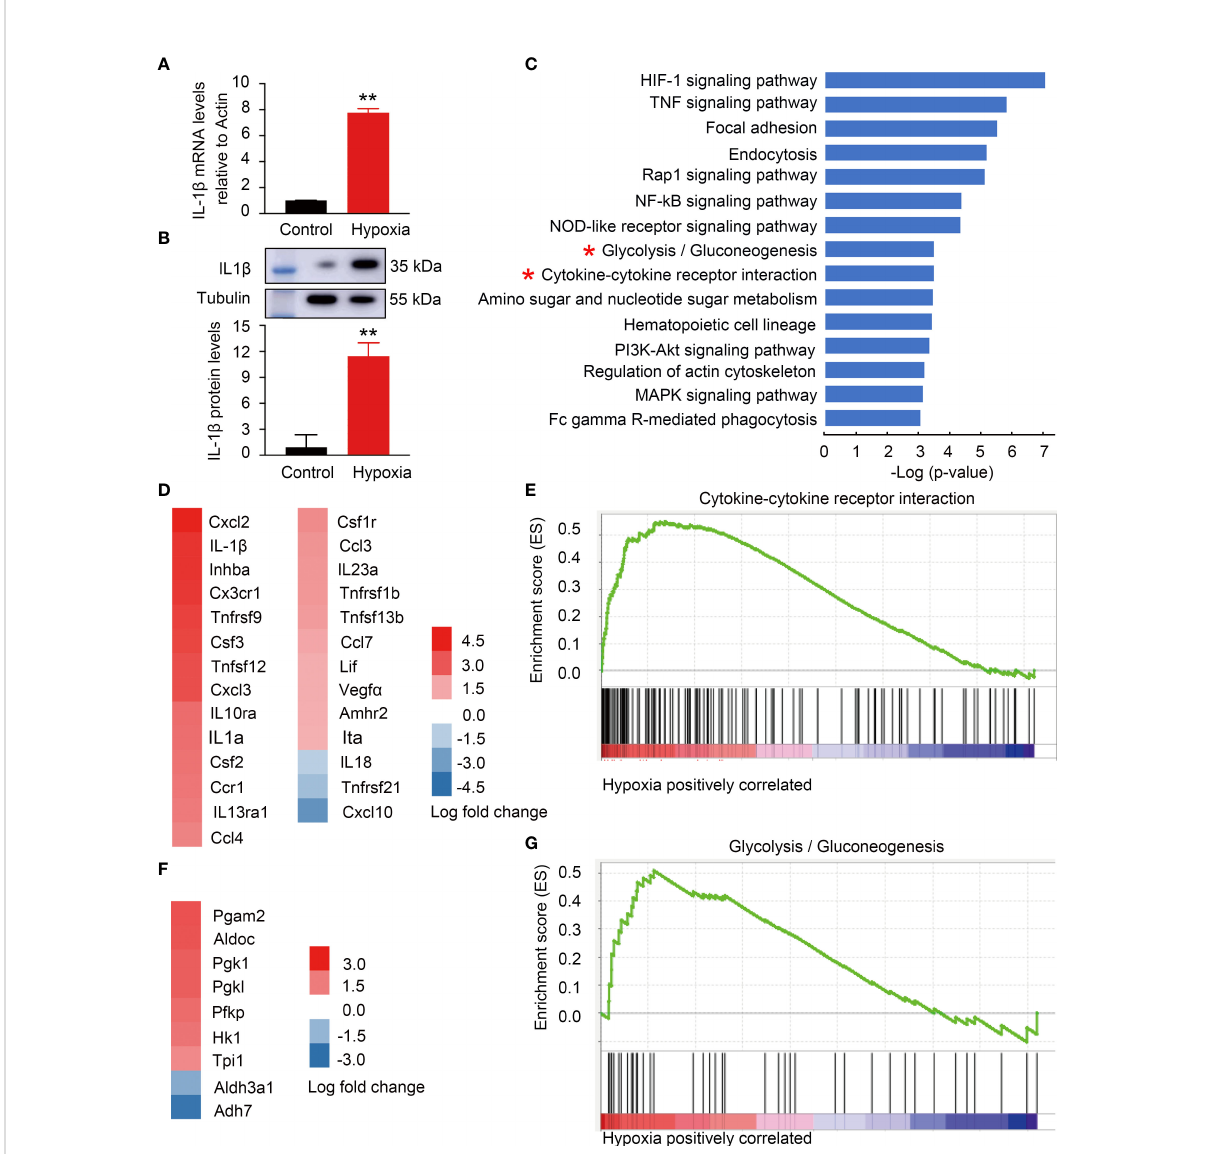
FIGURE 4 Hypoxia-induced BV2 activation with metabolic and in fl ammatory alterations mimicking activated retinal microglia (ARM) in DR. (A,B) Hypoxia- induced IL-1 b expression at mRNA and protein levels using RT-PCR and western blot. (C) GSEA revealed in fl ammatory and metabolism-related pathways enriched in BV2 cells response to hypoxia. (D,E) Fold change heatmap of differential expressed genes in “ Cytokine-cytokine receptor interaction ” signature gene set against the ranked list of genes. Data represent the average of three control and three hypoxia stimulated cell samples. (F,G) Fold change heatmap of differential expressed genes enriched in “ Glycolysis ” signature gene set against the ranked list of genes. **p <